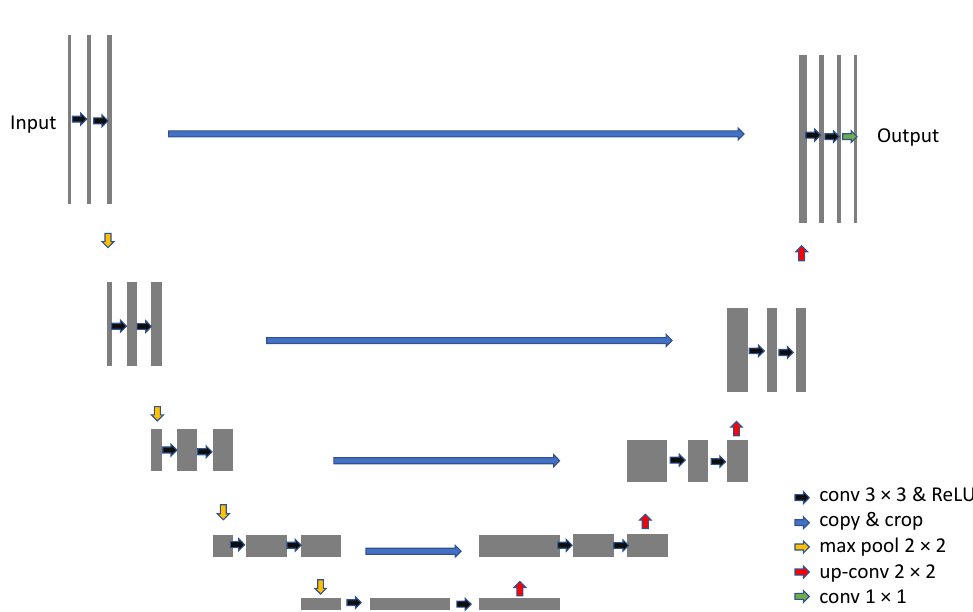
Figure 1. U-Net Architecture Reprinted with permission from Ref. [16]. 2015, Ronneberger, O.